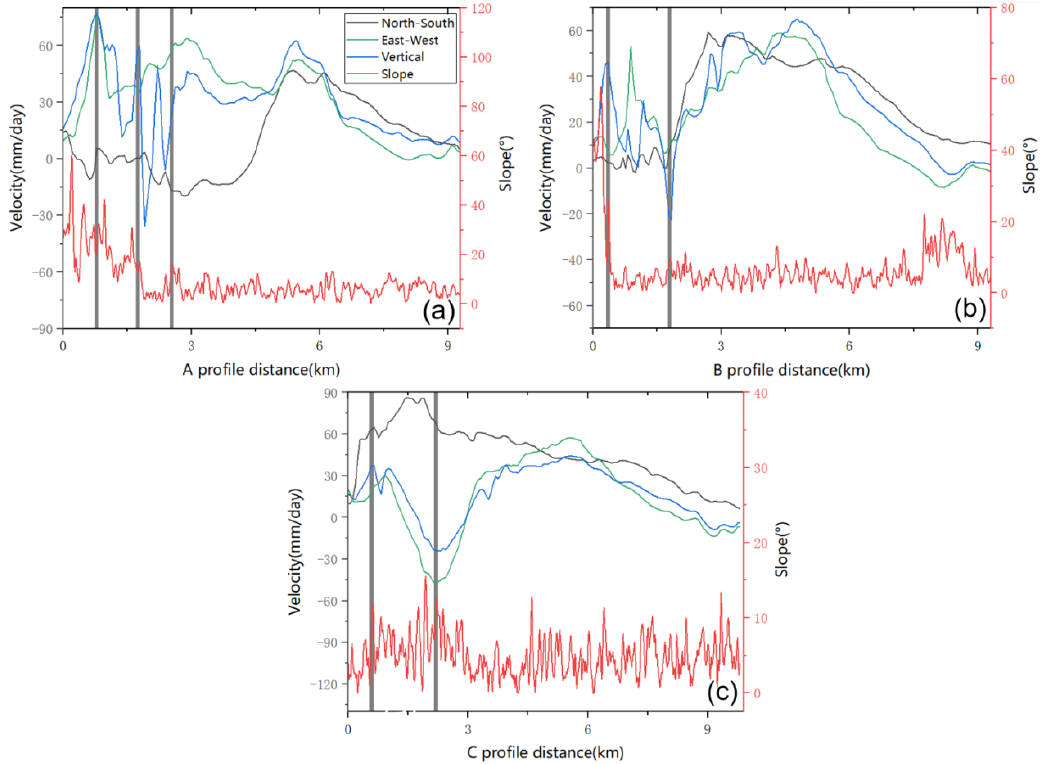
Figure 15. Comparison of profiles for glacier velocity and topographic profile (profiles along A, B, and C are shown in Figure 7a). ( a ) Deformation velocity and slope of profile A; ( b ) Deformation velocity and slope of profile B; ( c ) Deformation velocity and slope of profile C.